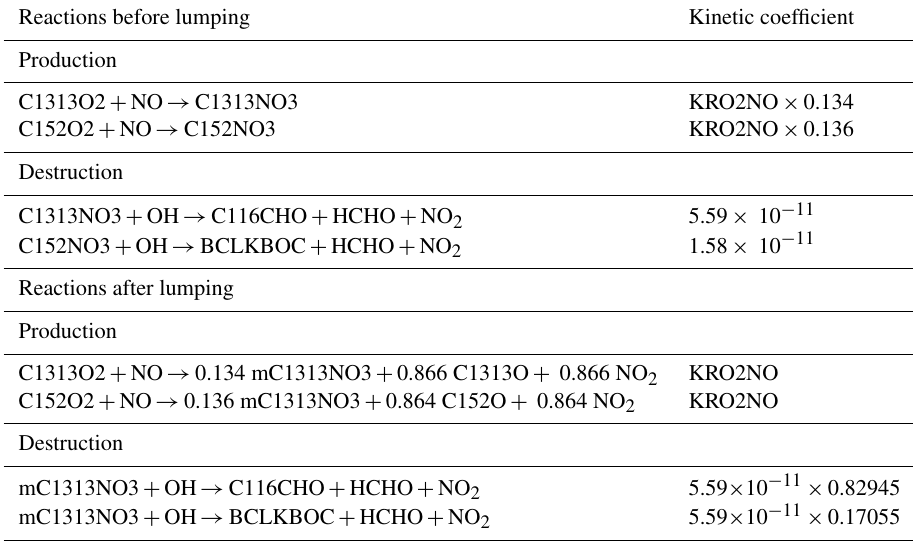
Table C2. Reactions related to the reduction of the MCM species C1313NO3 and C152NO3 via lumping. The exact weighting ratio of C1313NO3 is 0.82945, and the exact weighting ratio of C152NO3 is 0.17055.